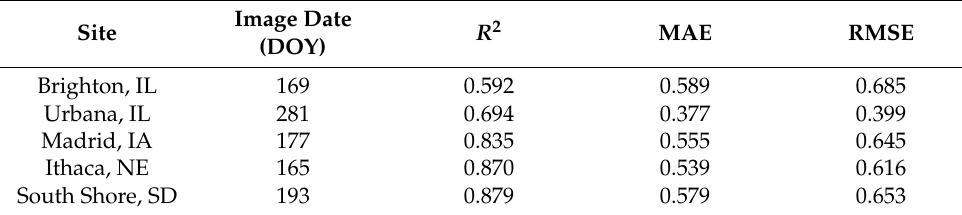
Table 6. Performance of linear regression models using the green normalized difference vegetation index 1 and characteristics of perennial grass dry biomass yield data used for model